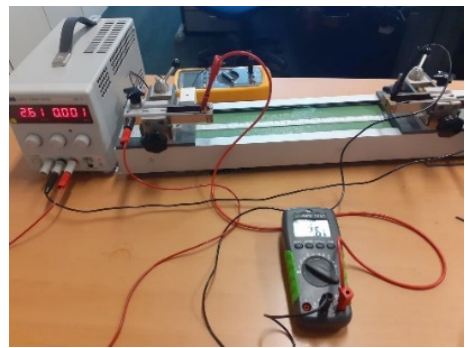
Figure 5. Measuring of length-dependent resistance (four-point clamping device).